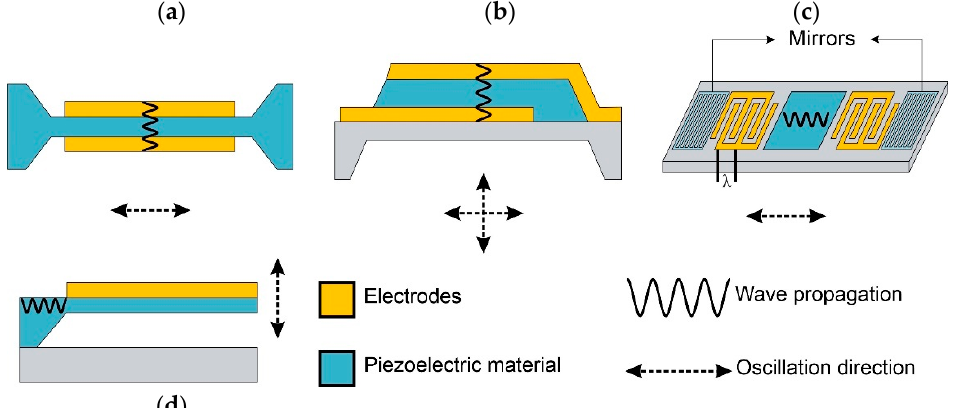
Figure 6. Schematics of electrical sensors. ( a ) Surface Acoustic Wave or SAW. ( b ) Quartz Crystal Microbalance or QCM. ( c ) Film Bulk Acoustic Resonator or FBAR. ( d ) Piezoelectric Cantilever Resonator or PCR.